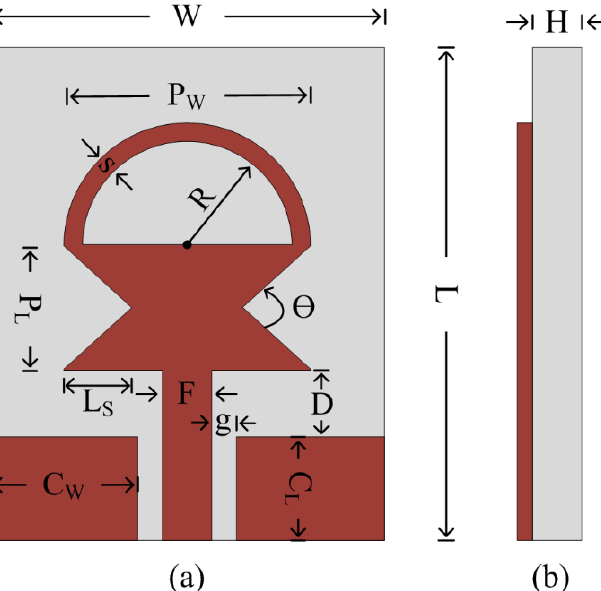
Figure 1. Geometry of the proposed antenna: ( a ) front view; ( b ) side view L = 20 mm; W = 15 mm; C L = 5.5 mm; C W = 6 mm; g = 0.5 mm; F = 2 mm; D = 2 mm; H = 0.254 mm; P L = 5 mm; P w = 13 mm; L s = 2.5 mm; R = 4.5 mm; s = 1.5 mm; θ = 90 ◦ .